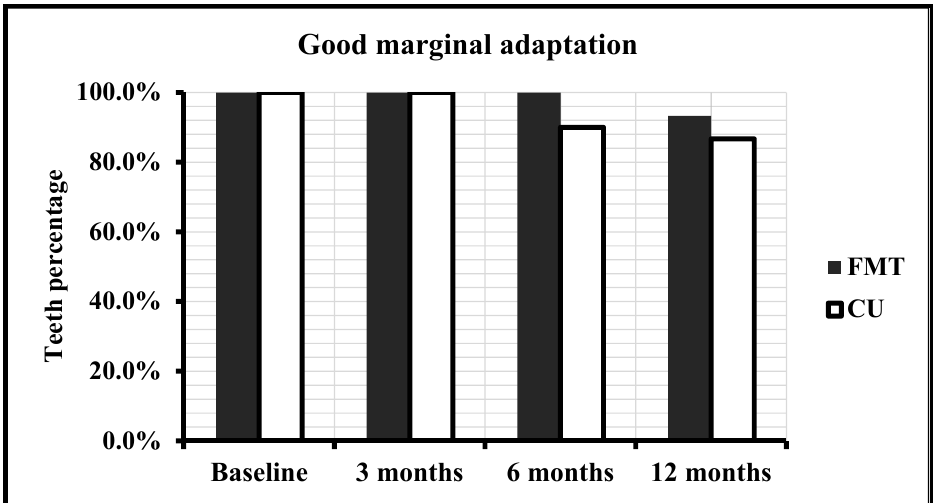
Figure 7. Marginal adaptation observed radiologically for FMBT and CULT over time.